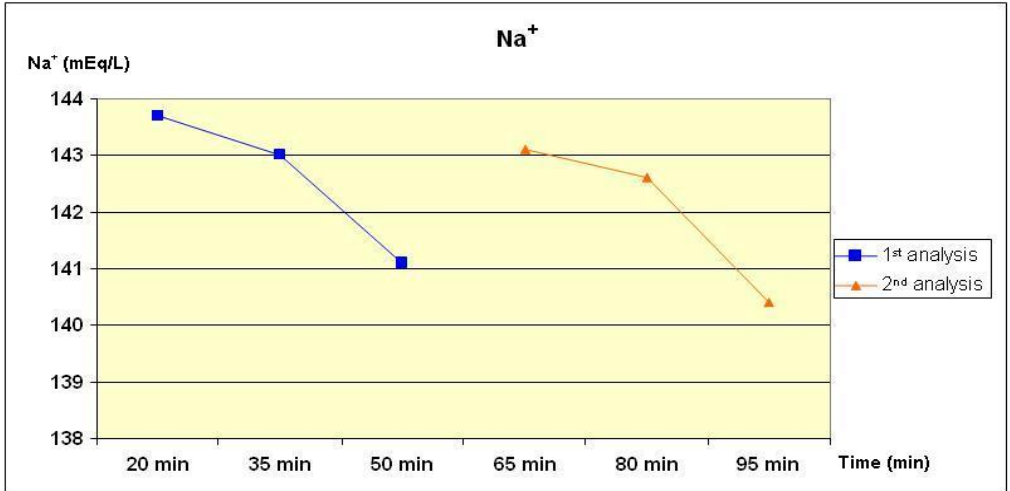
FIGURE 3 – Na + average values in the first and second gasometrical analysis during the blood storage on ice